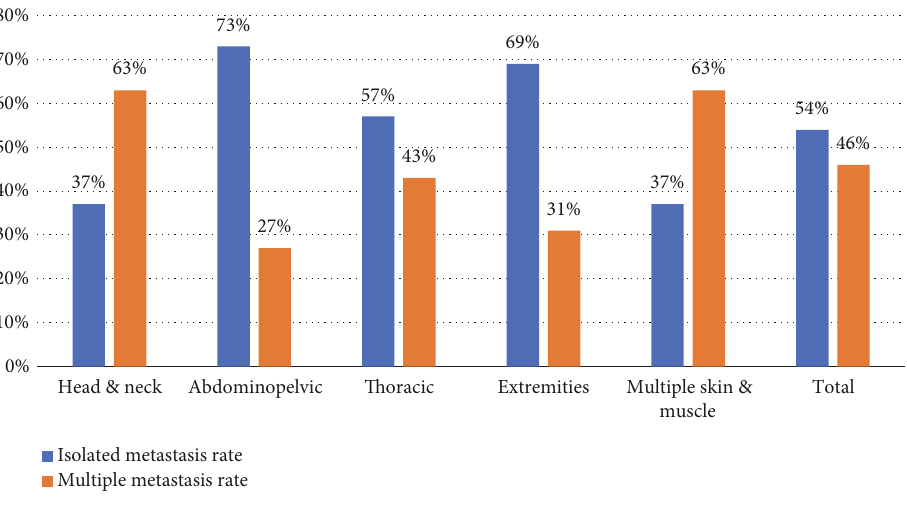
Figure 8: Metastasis features (isolated versus